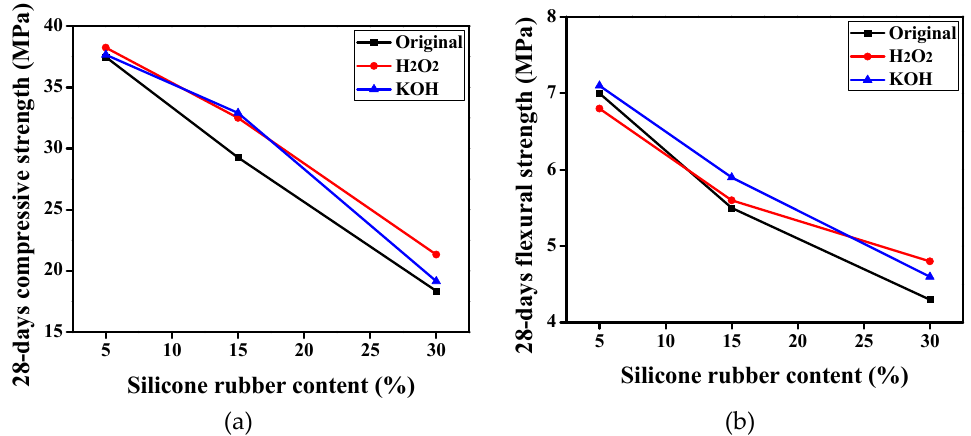
Figure 11. The 28-day mechanical strength of modified silicone rubber mortar. ( a ) Compressive strength; ( b ) Flexural strength.